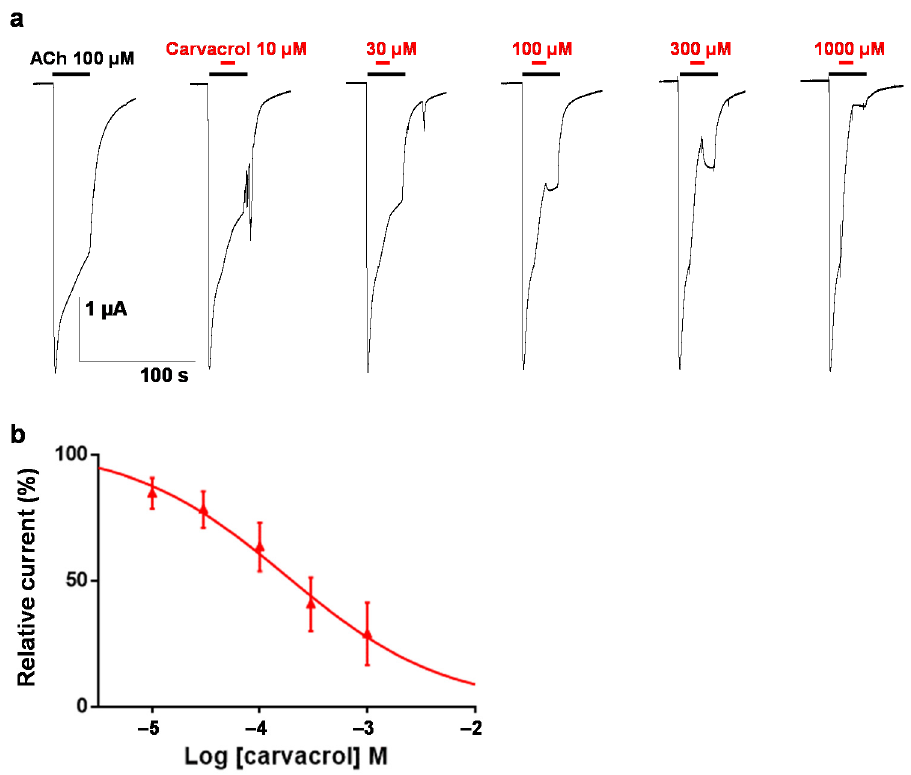
Figure 6. Concentration–inhibition relationship of carvacrol on the Parascaris sp. ACR-16 N-AChR expressed in Xenopus oocytes. ( a ) Representative current traces for single oocytes challenged with acetylcholine (ACh) in the presence of increasing concentration of carvacrol from 10 to 1000 µM. The concentrations of ACh and carvacrol (µM) are indicated above each trace. ACh was applied for 30 s intervals (black bars), and carvacrol was applied for 10 s (red bars). ( b ) Concentration–inhibition response curve of carvacrol. All responses are normalized to 100 µM ACh. Results are shown as the mean ± SE ( n = 6).